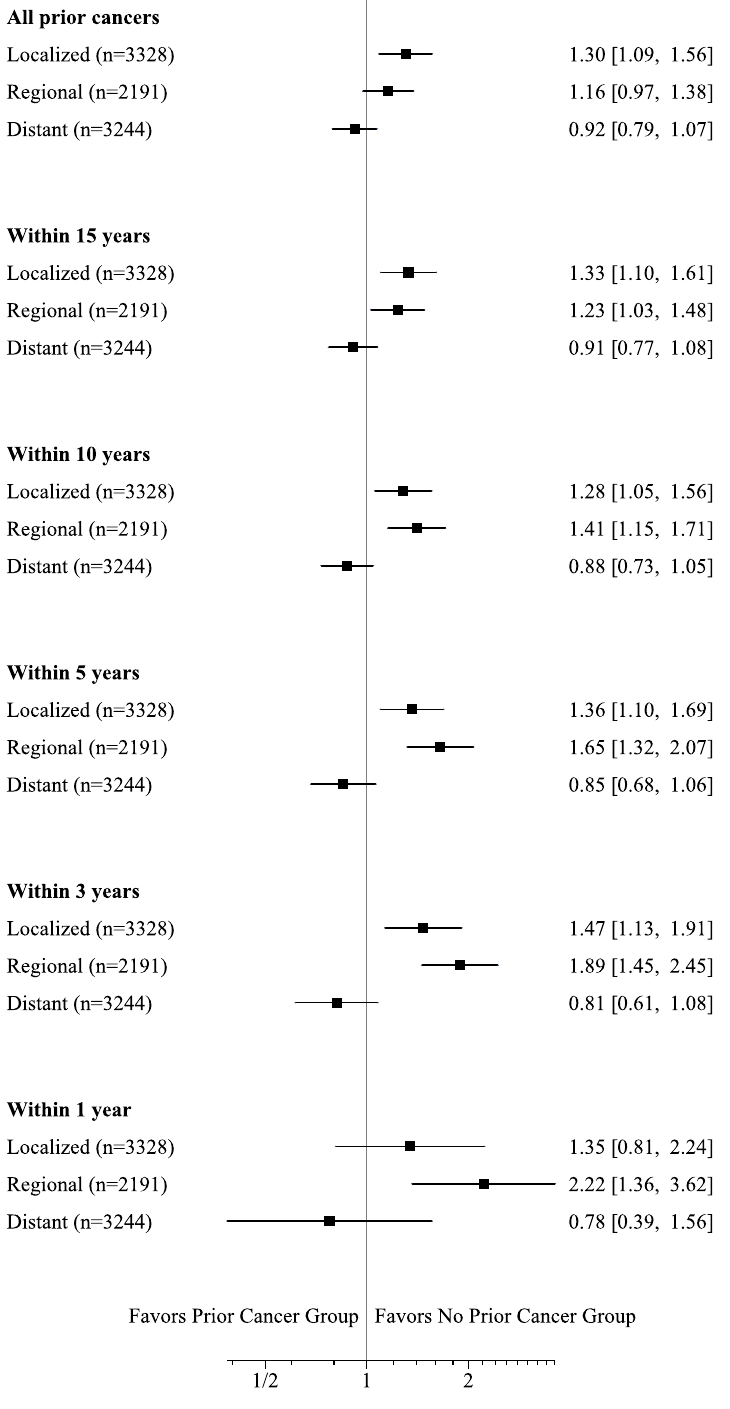
Figure 2. Impact of prior cancer on survival in NSCLC patients according to diagnostic time interval and index NSCLC stage. HRs were calculated using Cox proportional hazards models on all-cause mortality in NSCLC patients stratified by diagnostic time interval (between the most recent prior cancer and the index cancer) and index NSCLC stage. The No Prior Cancer Group was used as the reference category. For all diagnostic time intervals in these models, there were 3328 localized NSCLC patients, 2191 regional NSCLC patients, and 3244 distant NSCLC patients. Abbreviations: CI, confidence interval; HR, hazard ratio; NSCLC, non-small cell lung